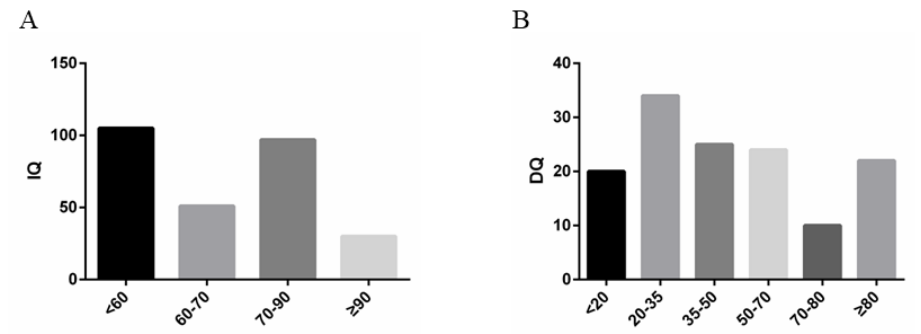
Figure 3. ( A ). IQ of children over 6 years old at enrollment. ( B ). DQ of children under 6 years of age at enrollment.